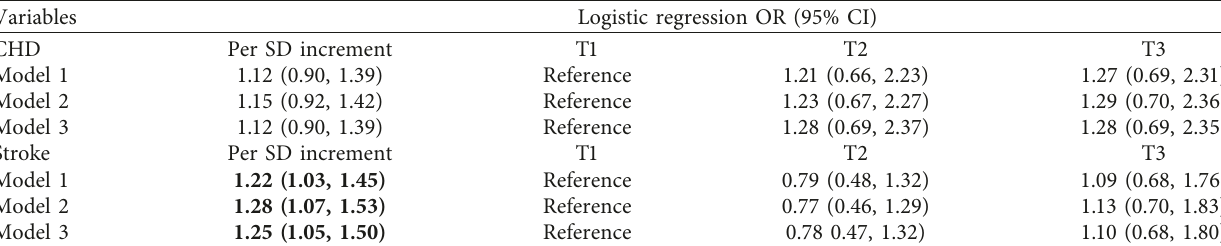
Table 2: Logistic regression analysis of associations between cortisol and